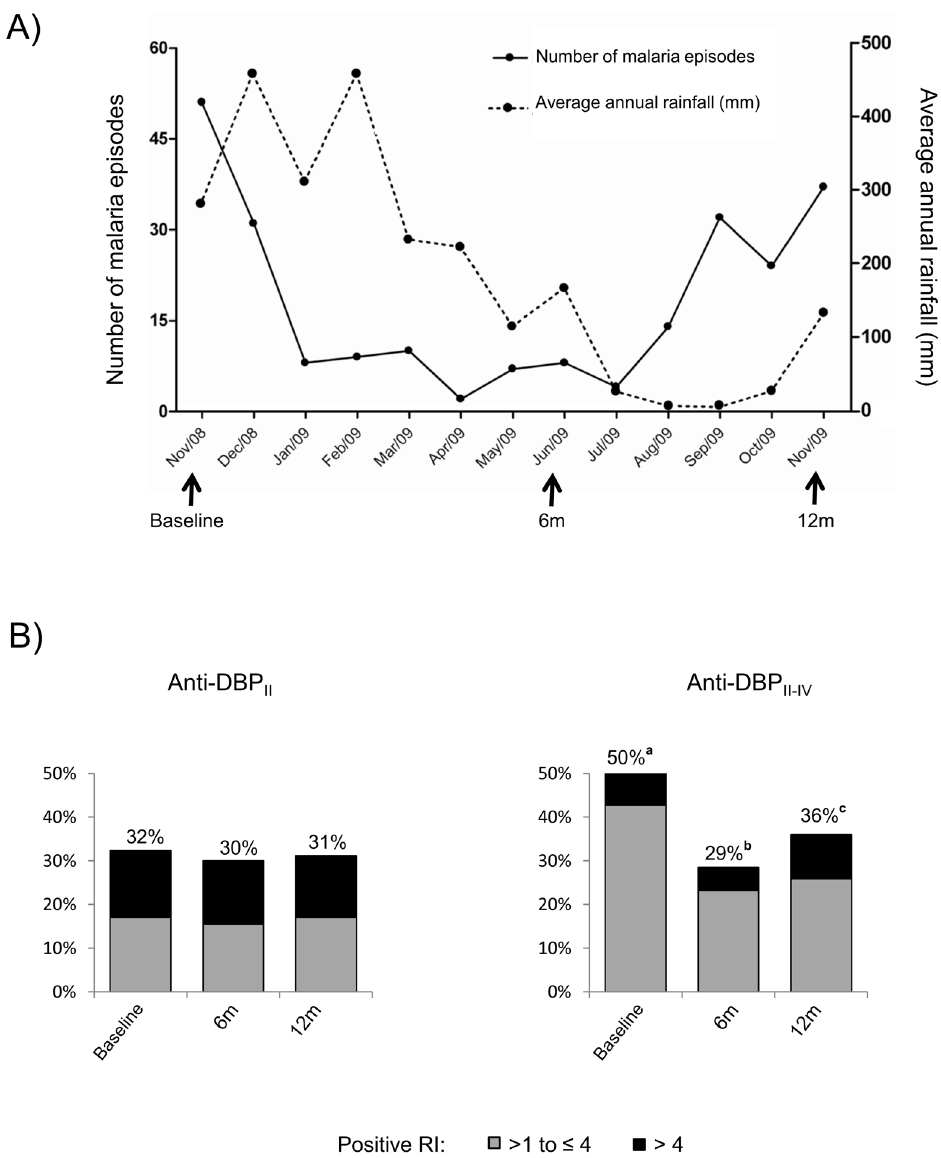
Figure 1. Temporal distribution of P.vivax malaria episodes and serological evaluation of ELISA-detected IgG antibodies targeting PvDBP, Amazonas, Brazil (Nov 2008-Nov 2009). (A) Episodes of malaria, as detected by conventional microscopy, varied according to rainfall and season; (B) DBPII-IV antibodies fluctuate with season while anti-DBPII remains stable. ELISA-detected antibody responses were evaluated November 2008, June 2009, and November 2009. Results are expressed as frequency (%) of responders, with Reactivity Index (RI) . 1.0 considered positive; different superscripts (a–c) indicate significant differences (P , 0.05 by Z-test.)